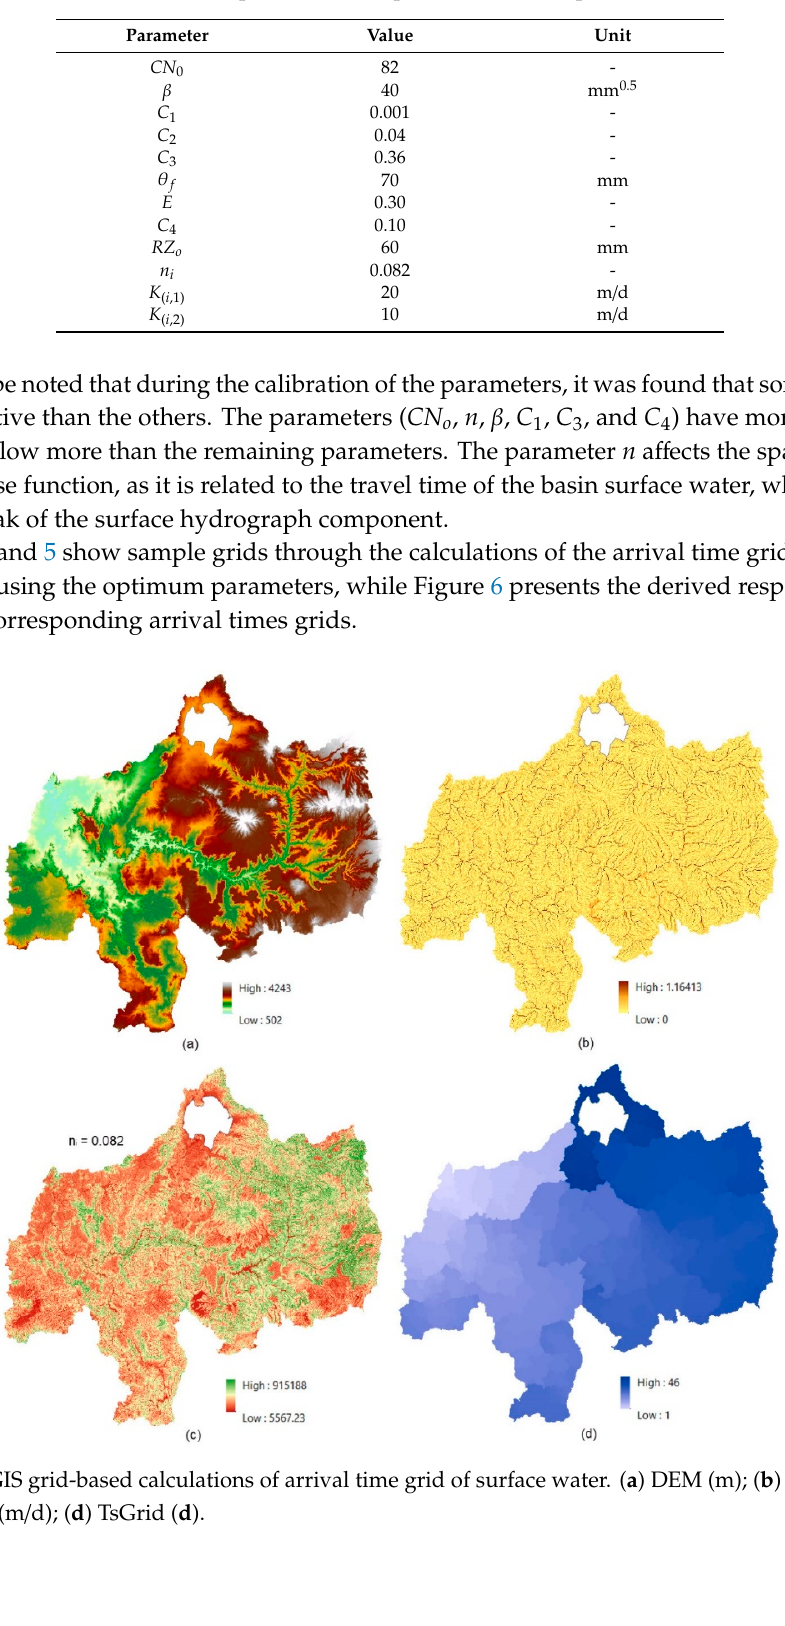
Table 2. The optimum model parameters in lumped mode.